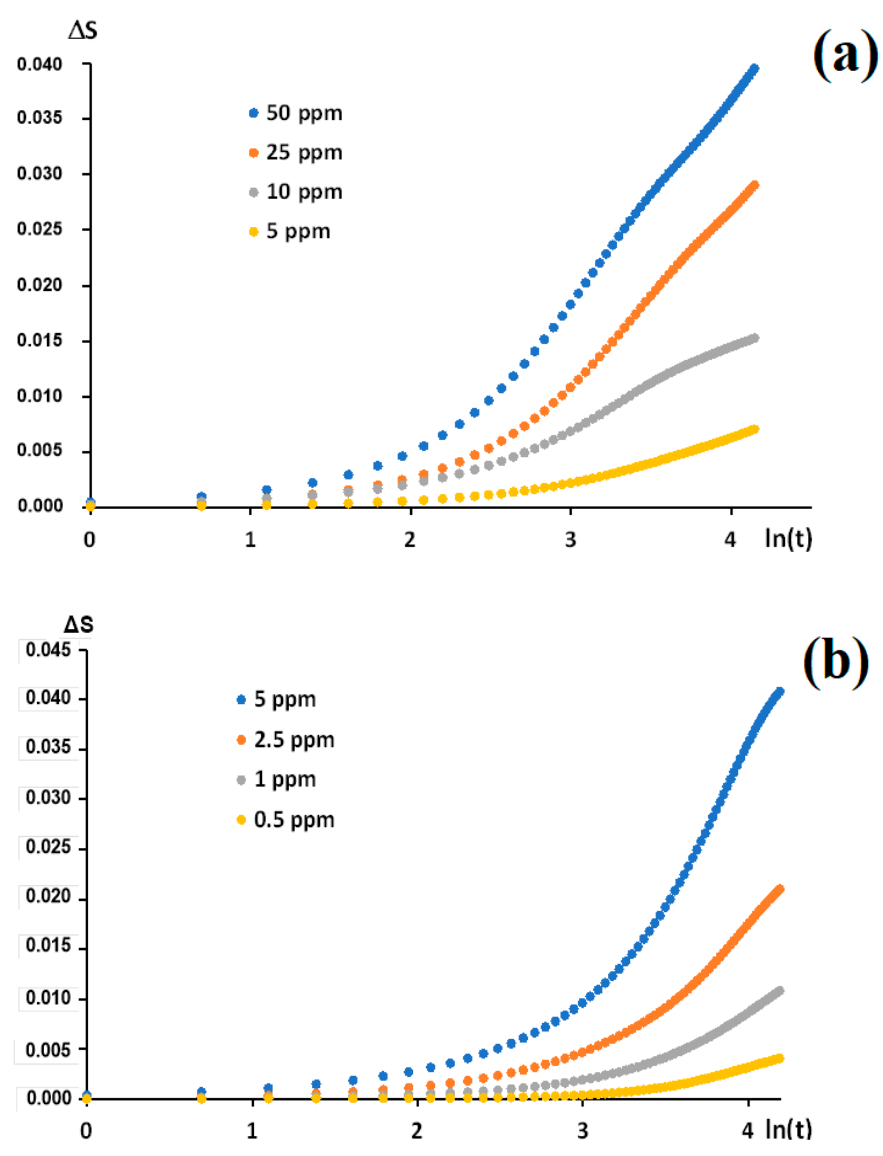
Figure 9. The dependences ∆ S vs. ln ( t ): ( a ) Type 1 sensor; ( b ) Type 2 sensor. The slope of the graph, ∆ S vs. ln ( t ) in the area of the extrema, S ′ ( t ), was taken to build the calibration curve. The resulting graph is shown in Figure 10.